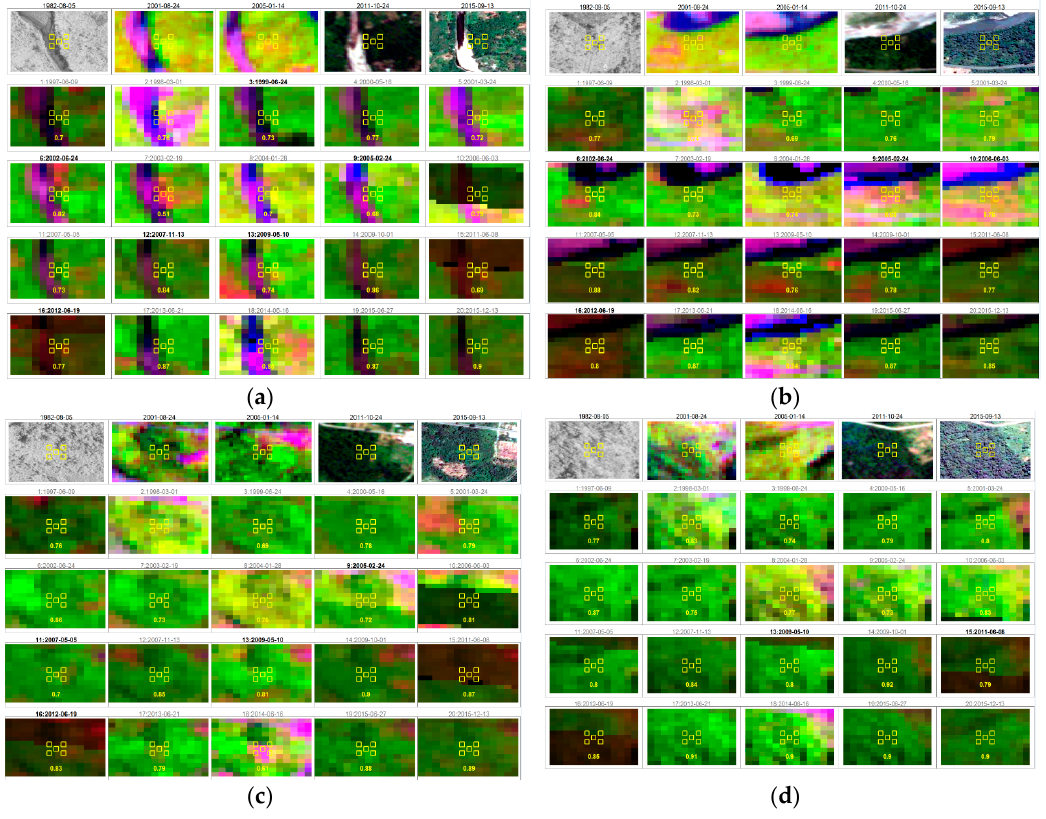
Figure 9. Interphase for samples interpretation. First row (from left to right) refers to high resolution imagery composed by aerial photos (1982) and images from ASTER (2001 and 2006), Rapid Eye (2011) and Google Earth (2015). The rest of the image chips correspond to the LTS as yearly RBG composites. Following protocols, we interpret these cases as follows: ( a ) Sample rejected by unmasked river, ( b ) Forest gain after disturbance observed in the 3rd row, ( c ) Forest lost with a short regrown period, and ( d ) Stable forest sample.